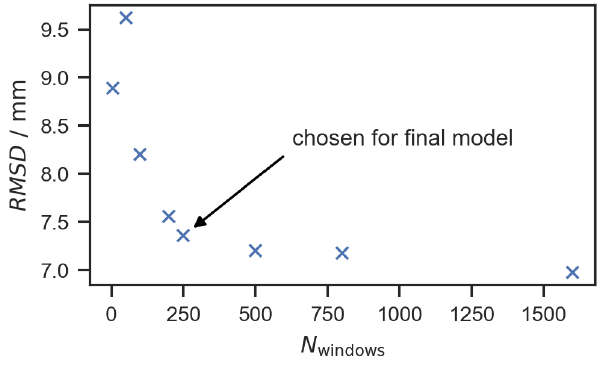
Figure 8. Results of the cross-validation for different numbers of time